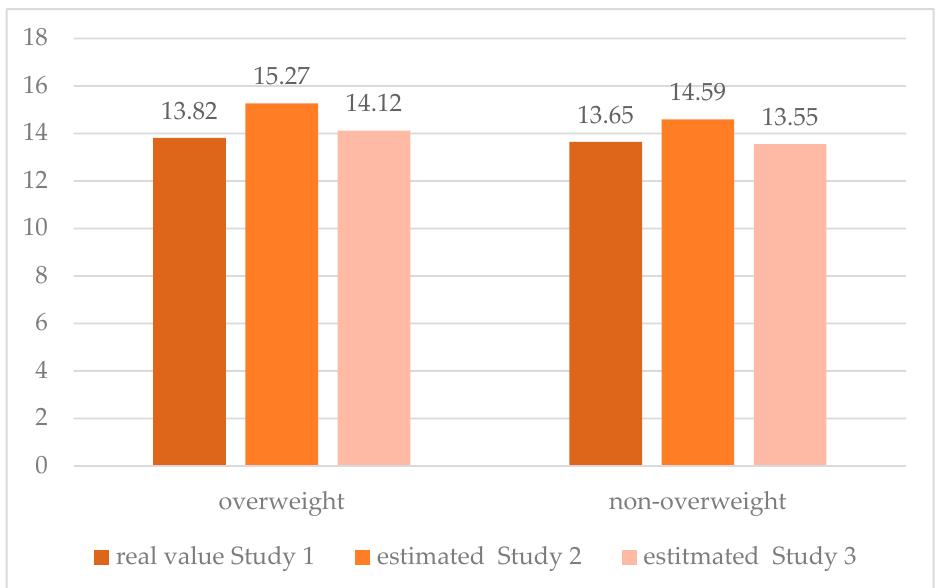
Figure 3. Changes in HBI in three waves of the survey under the Healthy Me program, according to body weight status groups adjusted for type of intervention, initial values of HBI, self-efficacy and interaction body weight status–self-efficacy.